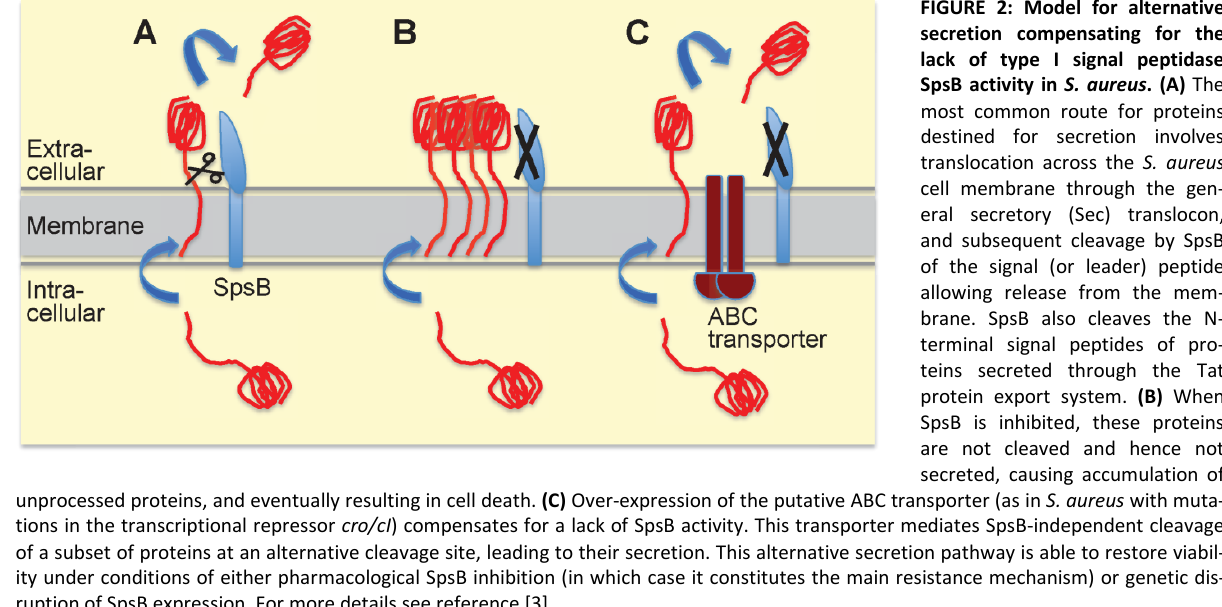
FIGURE 2: Model for alternative secretion compensating for the lack of type I signal peptidase SpsB activity in S. aureus . (A) The most common route for proteins destined for secretion involves translocation across the S. aureus cell membrane through the gen- eral secretory (Sec) translocon, and subsequent cleavage by SpsB of the signal (or leader) peptide allowing release from the mem- brane. SpsB also cleaves the N- terminal signal peptides of pro- teins secreted through the Tat protein export system. (B) When SpsB is inhibited, these proteins are not cleaved and hence not secreted, causing accumulation of